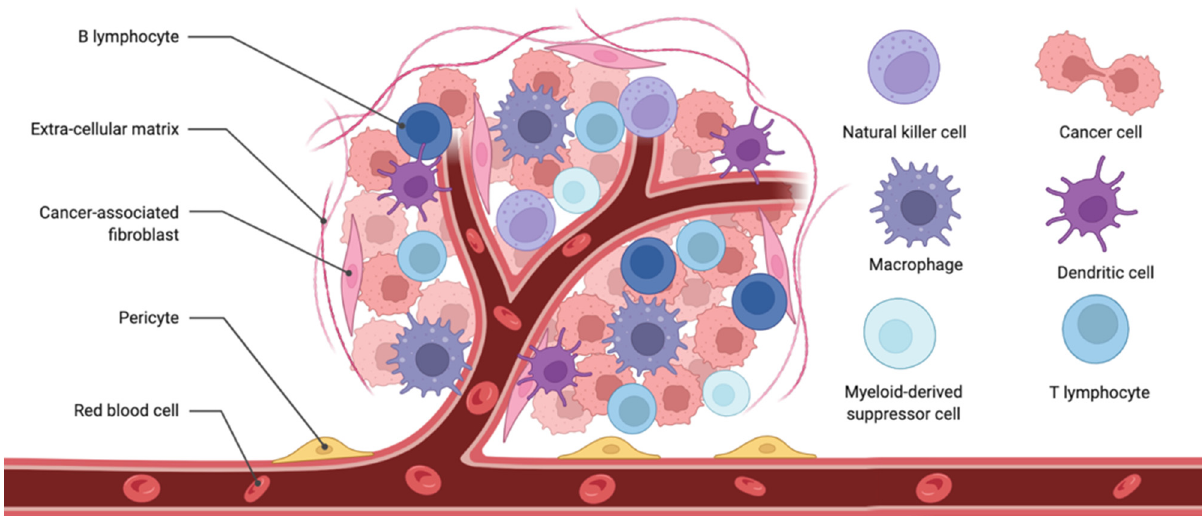
Figure 1. Scheme of tumour microenvironment.